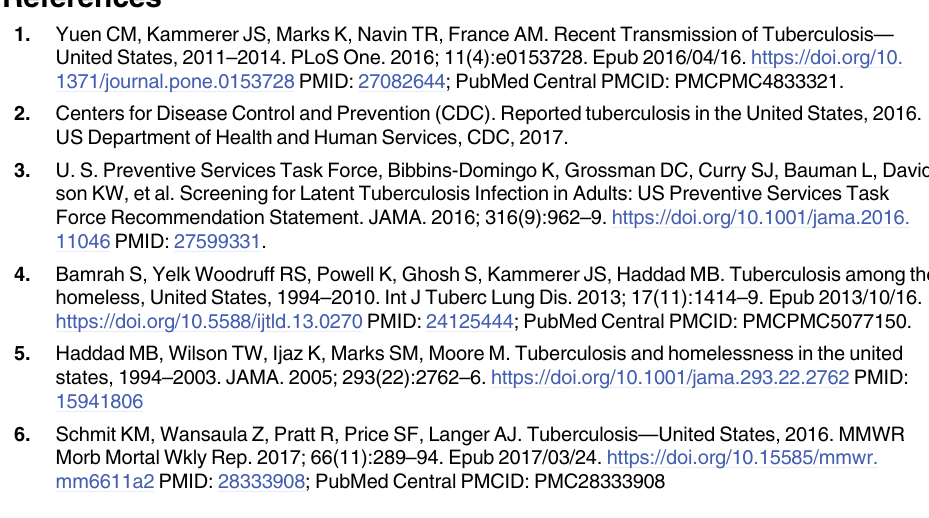
S1 Table. Contact list for 3HP